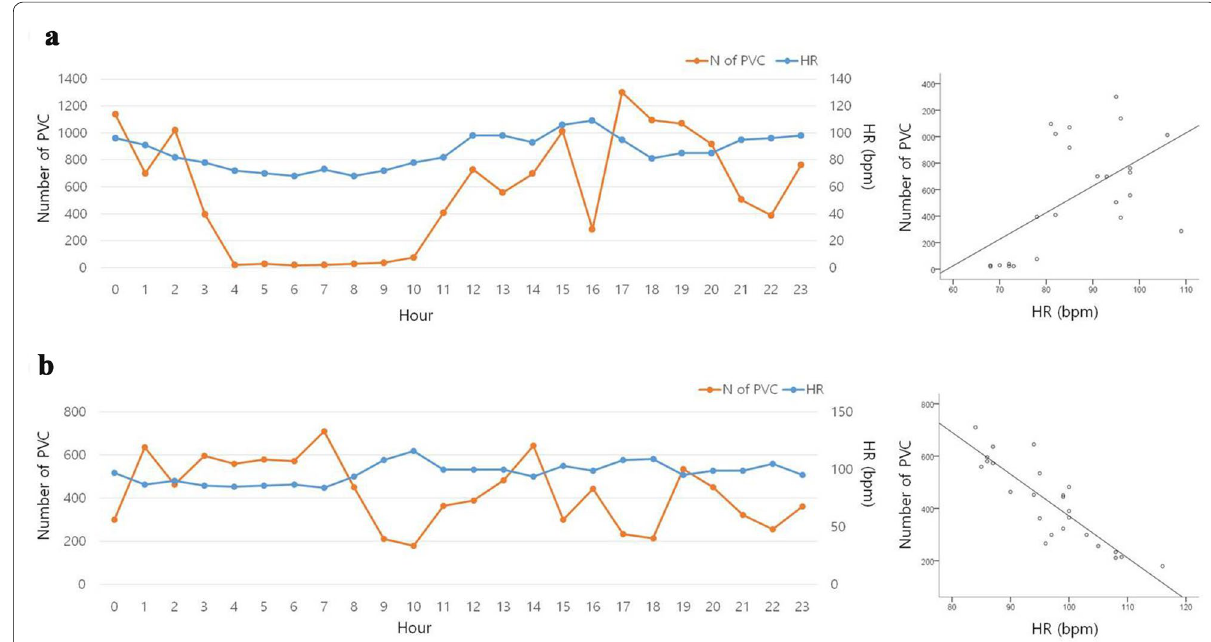
Fig. 1 Representative examples of fast rate‑dependent PVC (Group I) and slow rate‑dependent PVC (Group II) are